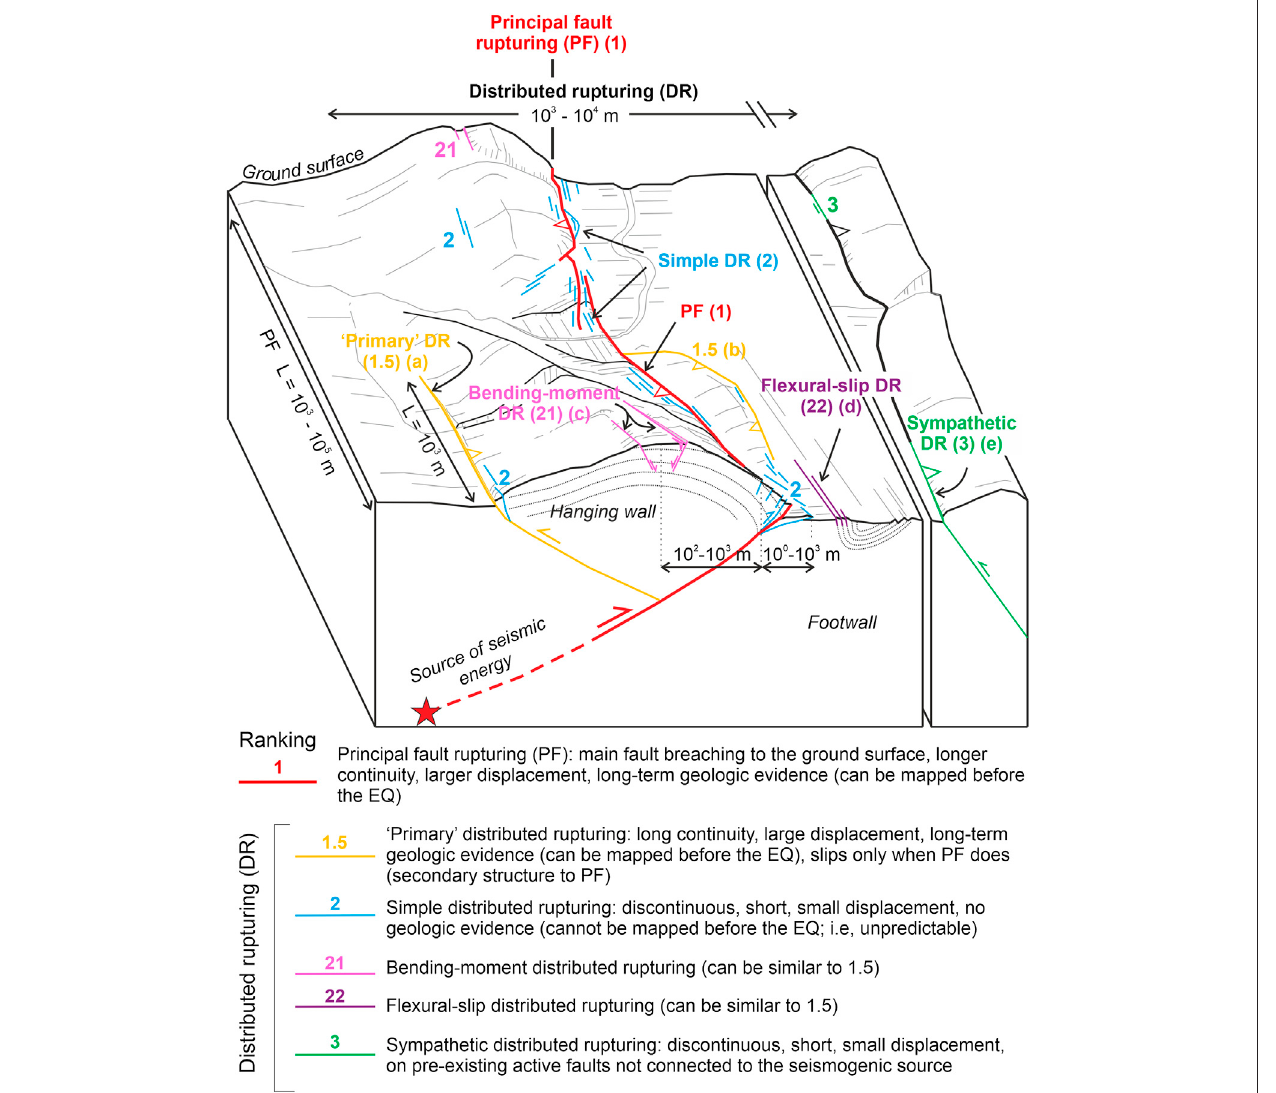
FIGURE1| Schematicillustrationoffaultrankingforreversefaults.Principalfaultrupture(1)isthesurfaceexpressionofthefaultresponsiblefortheearthquake,the other fault types being various kind of off-fault rupturing. Primary distributed rupturing (1.5) refers to the pre-existing faults that are connected to the principal fault in depth. These, however, rupture only together with the PF. Simple distributed rupturing (2) is the most general case of off-faulting, referring to the surface rupturing on unpredictable locations (not pre-existing faulting, or hidden small pre-existing faults). Bending-moment (21) and fl exural-slip (22) rupturing are both responses to large scale folding. Sympathetic rupturing (3) occurs along a pre-existing fault that is triggered usually for rather discontinuous rupturing. Complex DR inspired by (a) Tsautonback-thrustand(b)TsautonfrontalsyntheticsplayofChiChi1999rupture(Otaetal.,2007);(c)centralzone(normalfaultsatextradosoffoldsinthehangingwall of the main thrust), (d) northern zone (bedding plane slips in the sub-vertical limb of a footwall syncline), and (e) distant ruptures east of central zone of El Asnam 1980 rupture (Philip and Meghraoui, 1983). See Supplementary Figure S1 for examples of rupture ranking.